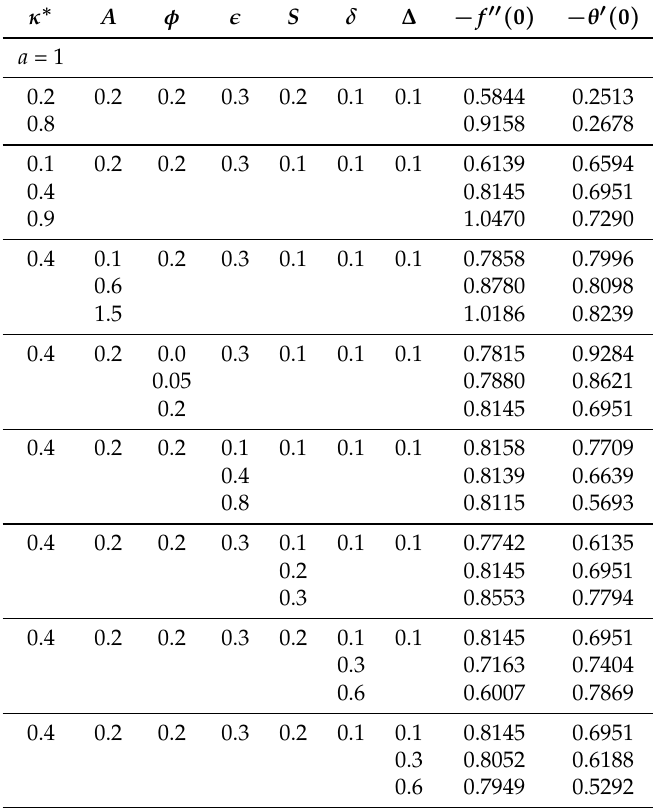
Table 2. Values of skin friction = − f (cid:48)(cid:48) ( 0 ) and Nusselt number = − θ (cid:48) ( 0 )